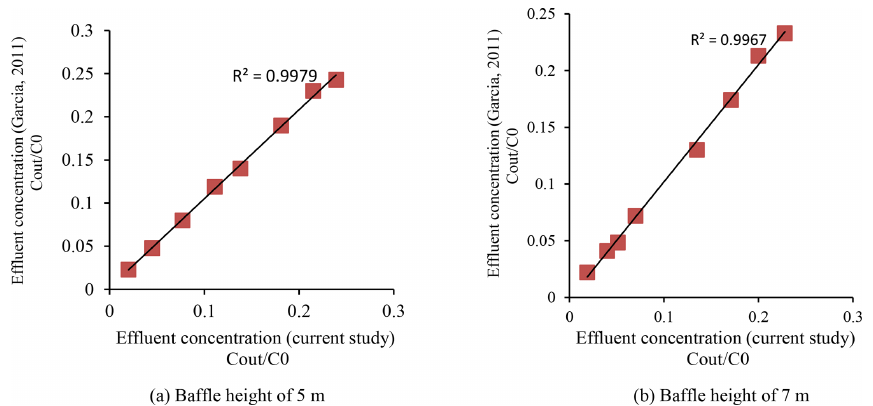
Figure 4. Data dispersion in current and Garcia studies